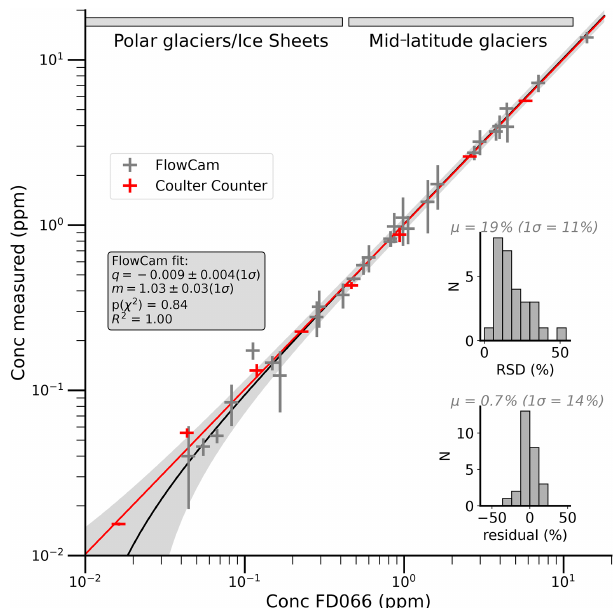
Figure 4. Comparison between nominal and measured concentra- tions of FD066 dust samples using the FlowCam and the Coulter counter. An orthogonal distance regression on the FlowCam data (black line with 3 σ confidence interval in gray) shows good lin- earity over 3 orders of magnitude. The red line refers to the linear fit on the CC data. The y error bars reflect 1 standard deviation of multiple repetitions of the same sample. All x errors are estimated as 10% of the FD066 prepared concentrations and account for the uncertainties in the dilutions and plastic adsorption effects. Both in- sets refer to the FlowCam measurements. The top inset shows the relative standard deviation (RSD) distribution, and the bottom in- set shows the distribution of the residuals, defined as the difference between the expected and measured concentrations. The top bars indicate the approximate ranges of dust concentration in polar and mid-latitude records.